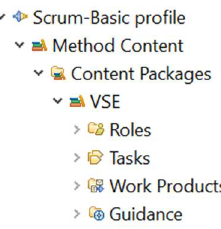
Figure 6. Prepared elements for the method content input in EPF Composer.